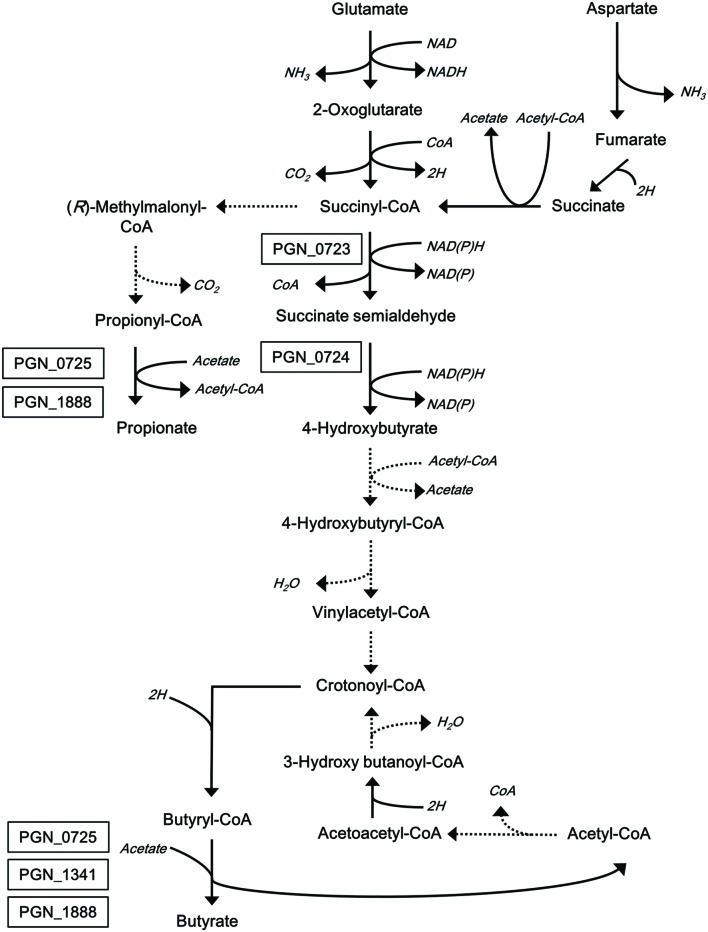
Proposed metabolic pathways for glutamate and aspartate catabolism in P. gingivalis. This scheme was constructed based on previous reports (Takahashi et al., 2000; Hendrickson et al., 2009). Broken lines indicate predicted pathways that have not been supported by experimental data. Associations of the boxed proteins with the pathways have been determined experimentally (Yoshida et al., 2015, 2016).